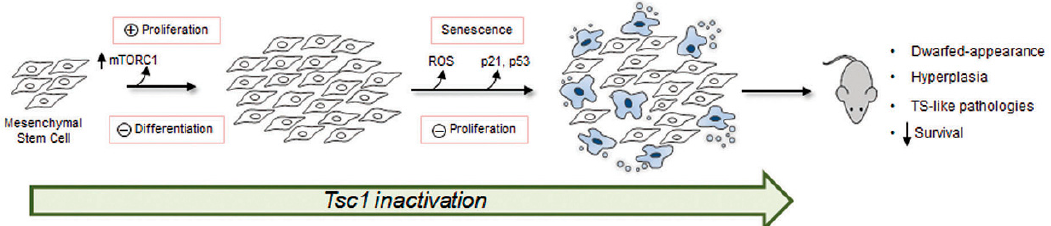
Figure 7. Proposed model showing downstream effects of Tsc1 inactivation in mesenchymal progenitors. Tsc1 loss causes transient amplification of the mesenchymal stem cells via hyperactivation of mTORC1. Proliferating cells maintain a progenitor (stem-like) state with impaired differentiation along mesenchymal lineages. Sustained hyperproliferation, during aging or following in vitro expansion, induces ROS accumulation and replicative senescence via the upregulation of p21 and p53. In vivo, Tsc1 loss culminates in defective skeletal development and hyperplasia affecting multiple organ systems including the heart and kidneys, ultimately reducing lifespan. Supplementary Materials: The following are available online at www.mdpi.com/xxx/s1, Figure S1: Specificity of Tagln -mediated recombination in LacZ reporter mice; Figure S2. Tsc1 is inactivated in BM-MSCs following Tagln-mediated recombination.